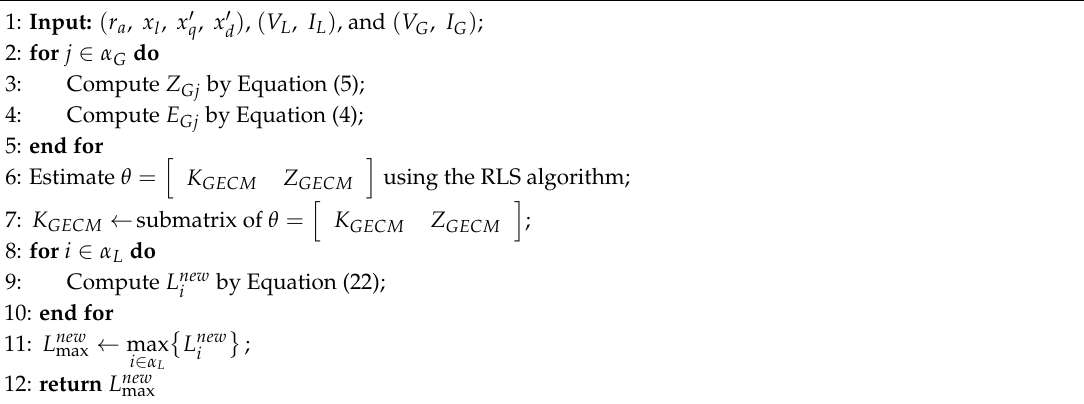
Algorithm 1 Proposed PMU-Based Algorithm to Voltage Stability